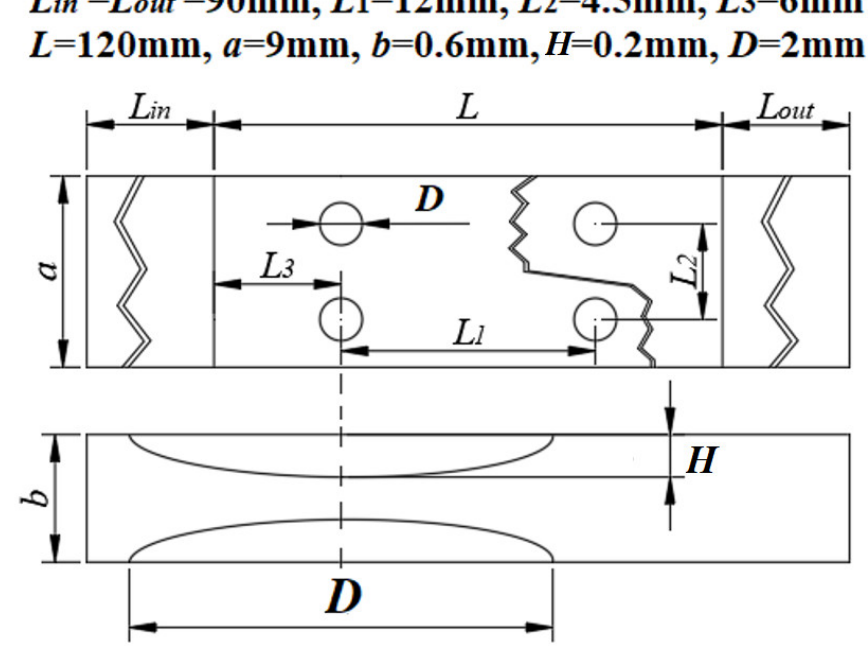
Figure 4. Geometric parameters of the microchannel with protrusions.